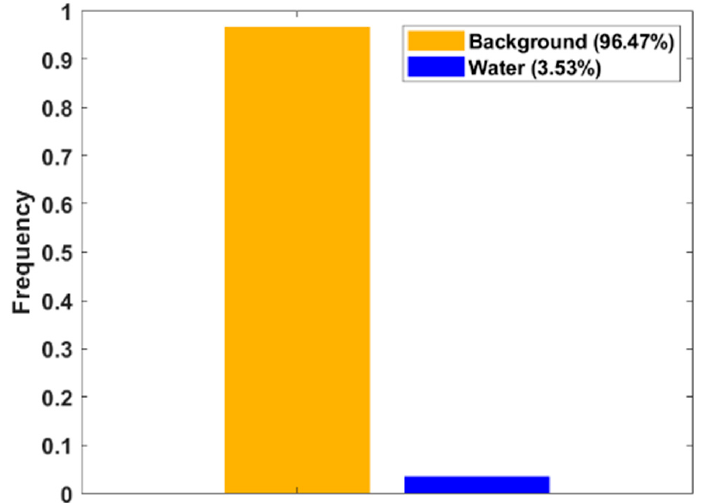
Figure 3. Frequency distribution of training classes pixel.